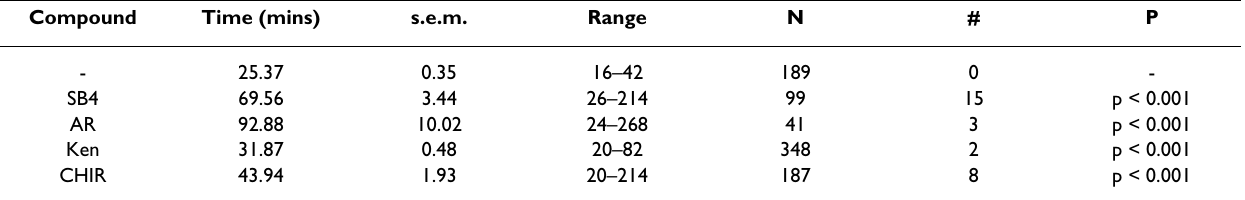
Table 3: Effect of GSK-3 inhibitors on mitotic timing and chromosome non-disjunction